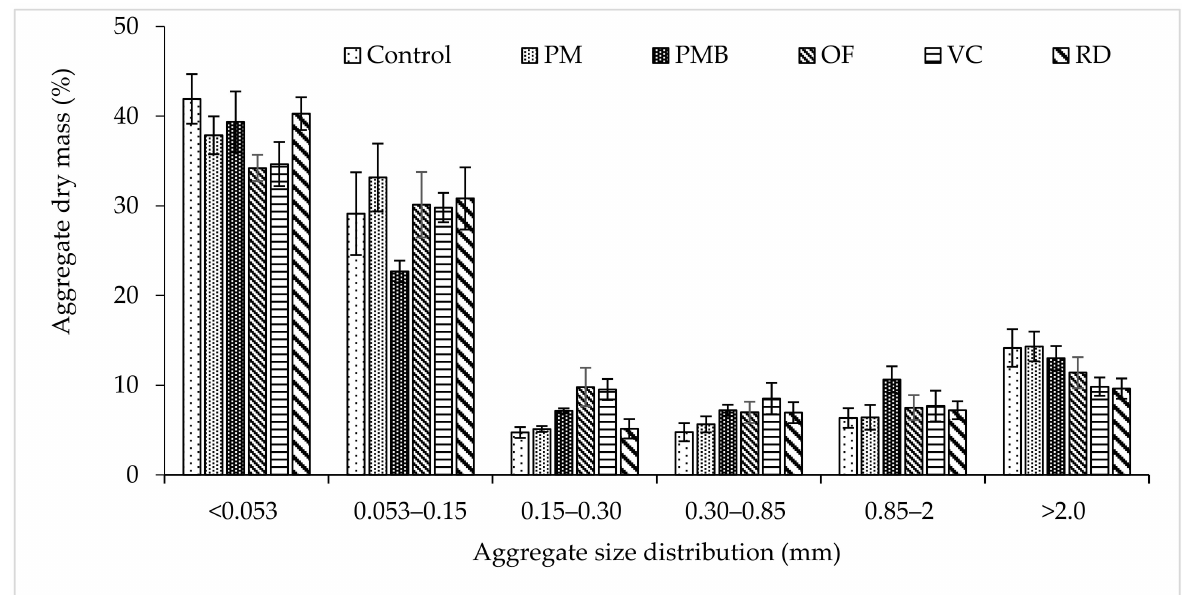
Figure 2. Distribution of different aggregate size fractions within 0–15 cm soil layer under different treatments in charland soil (bars = average and line = standard error of mean, SEM; n = 10). (PM = poultry manure, PMB = poultry manure biochar, OF = compost, VC = vermicompost, RD = recommended dose from only chemical fertilizer).